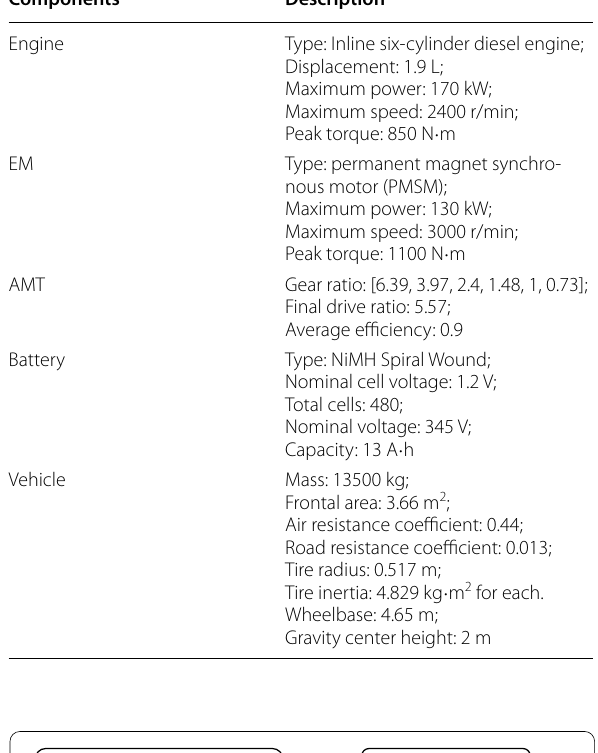
Table 1 Main parameters of the HEB